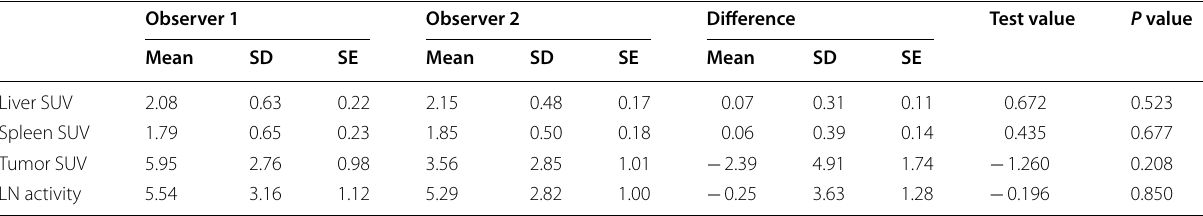
Table 2 Inter reader